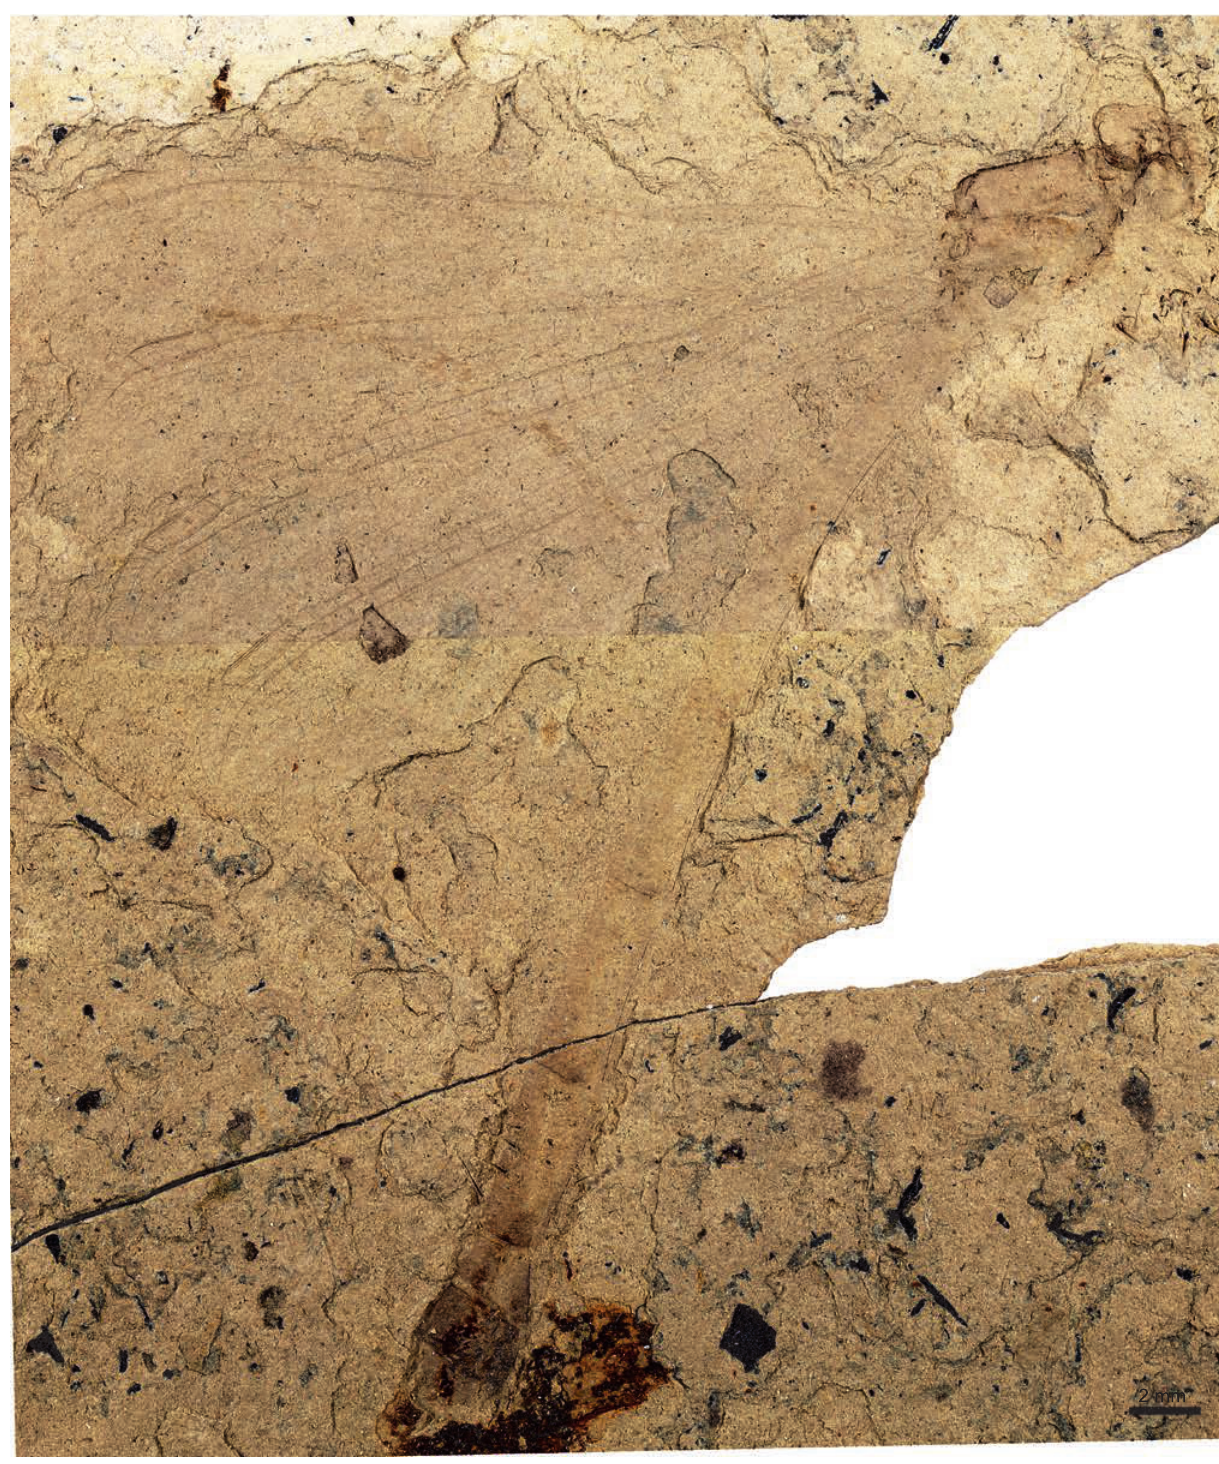
Fig. 8. Zygopteran odonatan Menatlestes palaeocenicus gen. et sp. nov., holotype MNT Nel Odo 2; from Paleocene, Menat, France. Habitus,